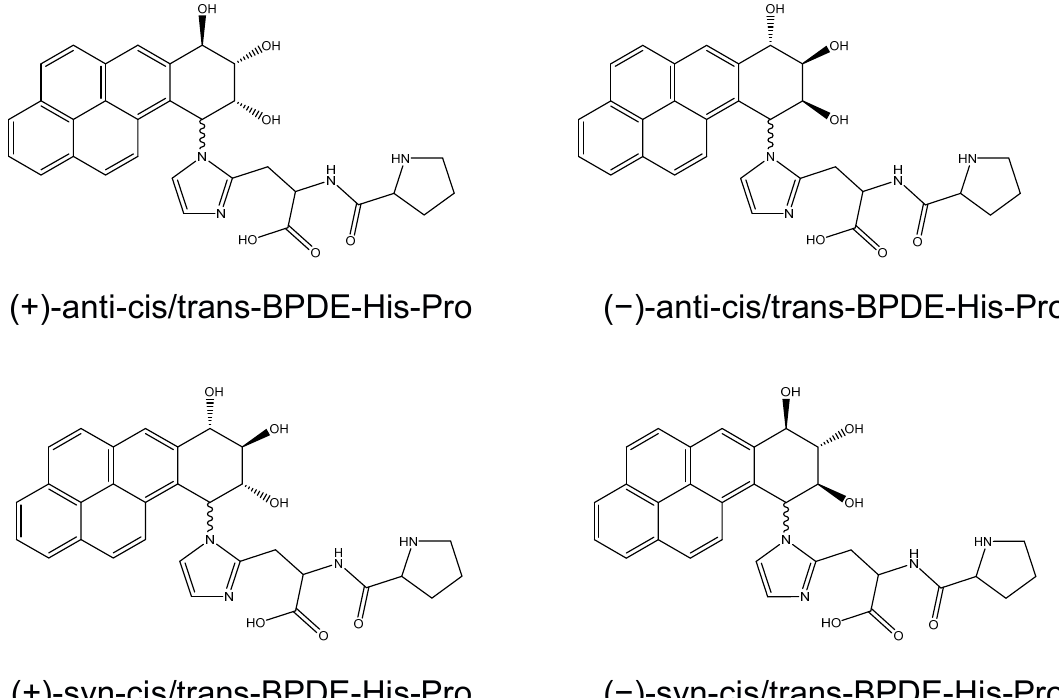
Figure 1. Structures of the studied His adducts in SA from (+/ − )-anti-BPDE and (+/ − )-syn-BPDE.